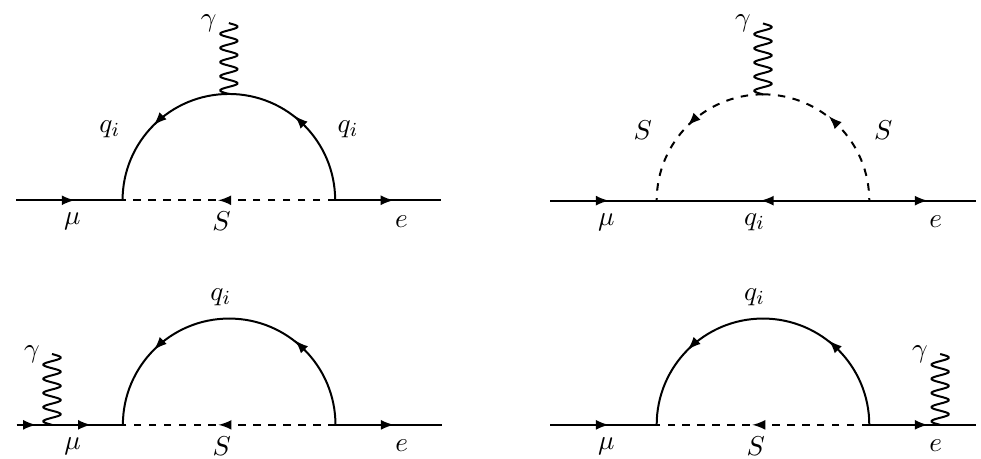
Figure 7 . There are four types of contributing diagrams to the (cid:22) ! e(cid:13) process. For our model, each of the four diagrams represents diagrams with either the S 4 = 3